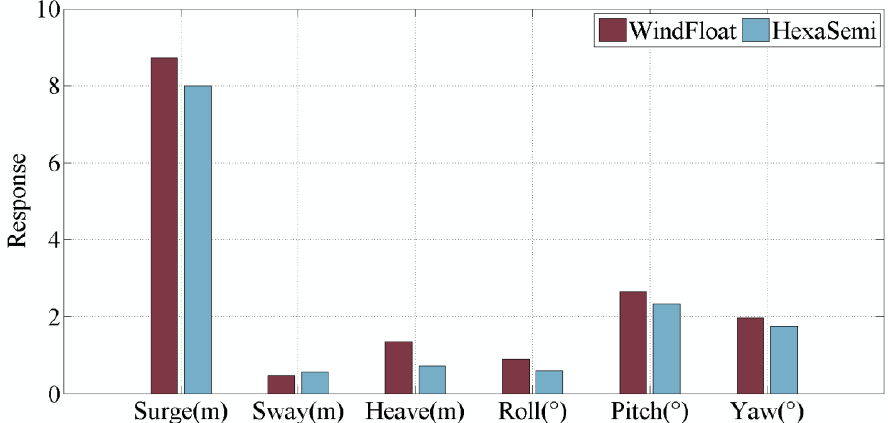
Figure 11. Comparison of 6-DOFs significant responses between the WindFloat-type platform and HexaSemi under the operational condition.